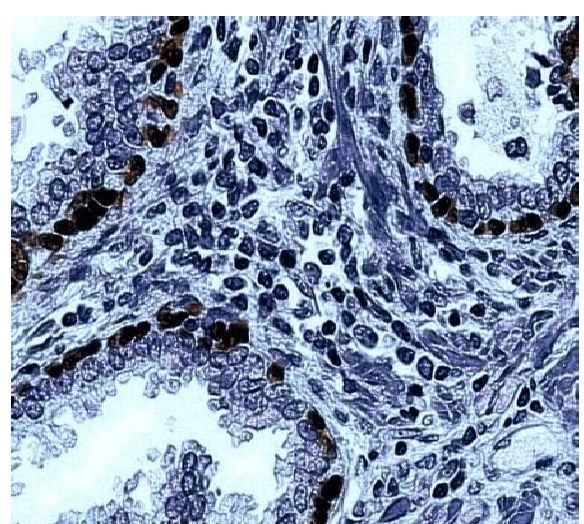
Fig(2) HG-PIN , show basal cell , brownish nuclear staining for p63 , x20